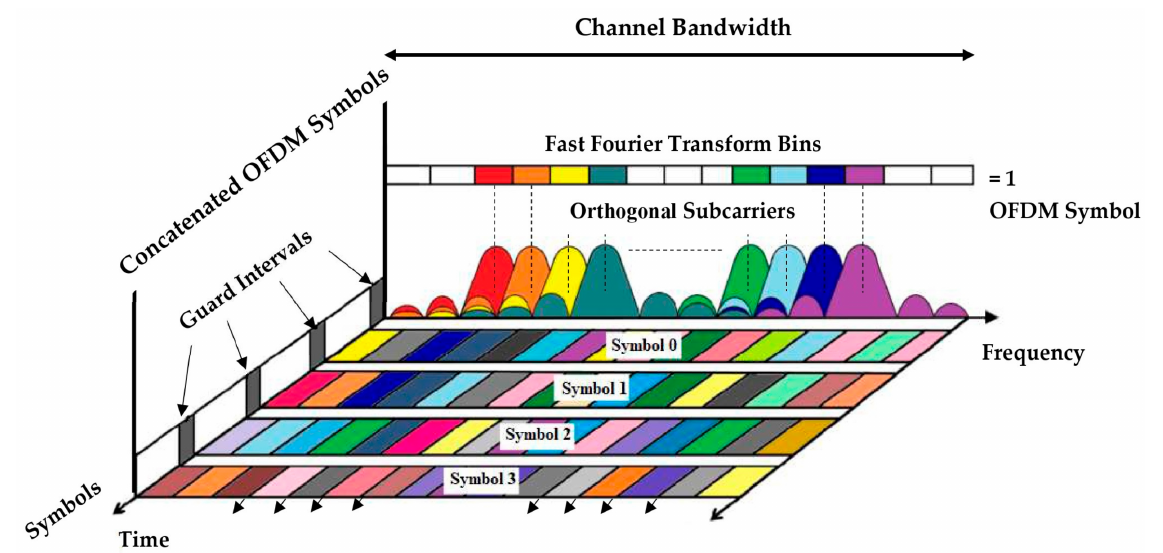
Figure 3. Demonstration of OFDM data in the time and frequency